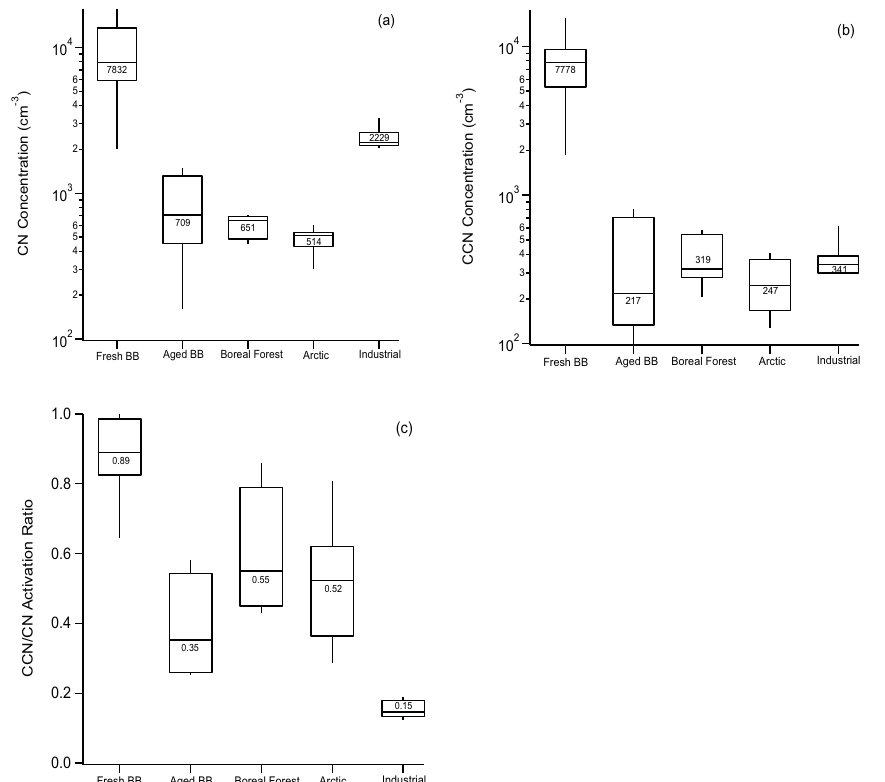
Fig. 3. Aerosol (CN) particle concentration (diameter > 10nm) (a) , CCN particle concentration at 0.55% supersaturation (b) and CCN/CN activation ratios at 0.55% supersaturation (c) . Horizontal bars and corresponding values in the boxes represent median concentrations, the box defines the first and third quartiles, and the bars represent the 10th and 90th percentiles. Biomass burning is abbreviated